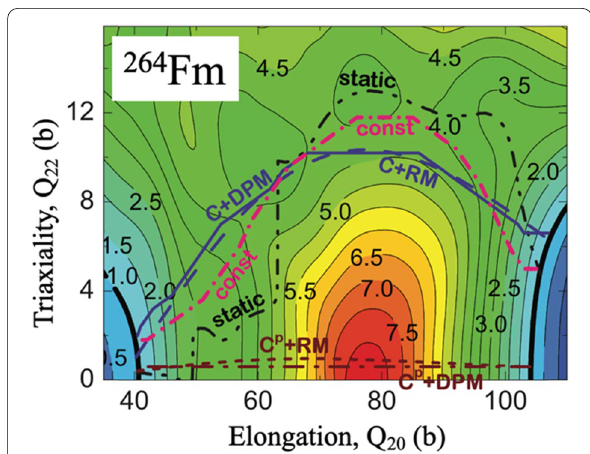
Fig. 10 Dynamic paths for spontaneous fission of 264 Fm, calculated for the nonperturbative (“C DPM”, “C RM”) and perturbative + + DPM”, “C p RM”) cranking inertia using DMP and RM techniques. (“C p + + The static pathway (“static”) and that corresponding to a constant inertia (“const”) are also shown. The figure is adapted from [75]